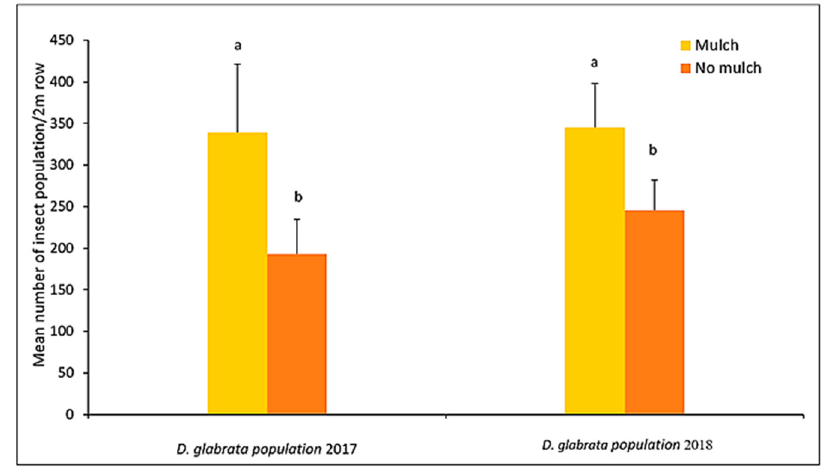
Figure 1. D. glabrata population (Mean ± SE) in mulched and without mulched plots during the two-year period. Different letters within the same year indicate significant difference (Fisher’s LSD, p < 0.05).